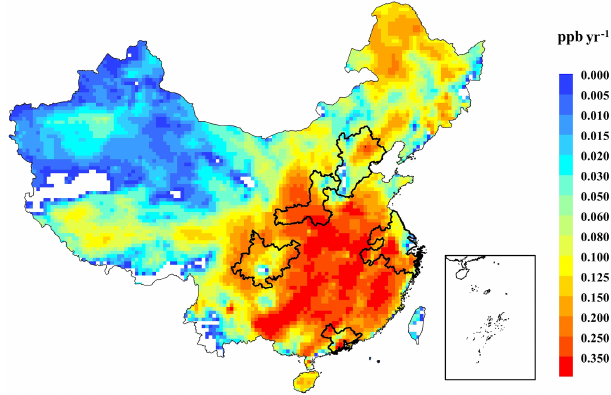
Figure 5. Spatial distribution of interannual variations in O 3 simu- lated using annual BVOC emission